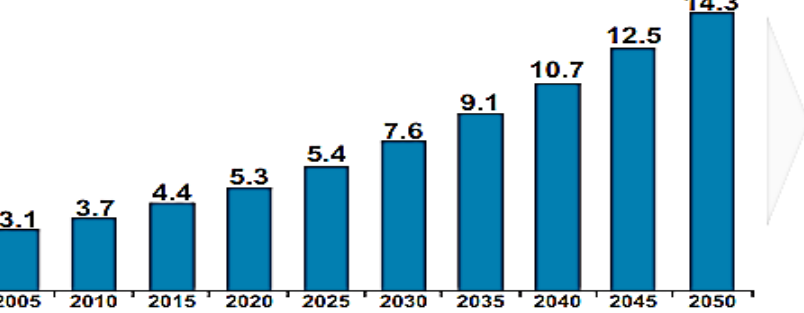
Figure 1. Individuals affected with dementia (in millions) [Source: http://ardsi.org (accessed on 5 May 2022)].